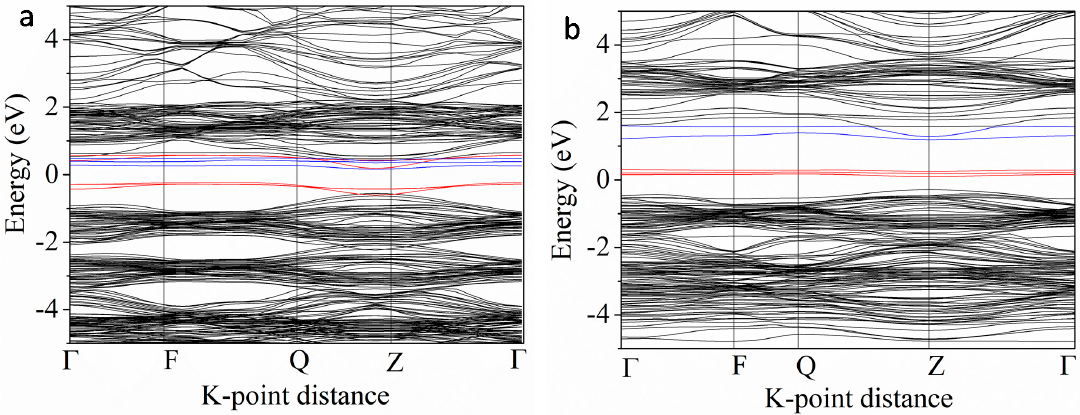
Figure 5. The band structures of the V-Cr ( a ) and V-Co ( b ) co-doped BaTiO 3 . The red lines indicate Cr 3d states or Co 3d states. The blue lines indicate V 3d states.